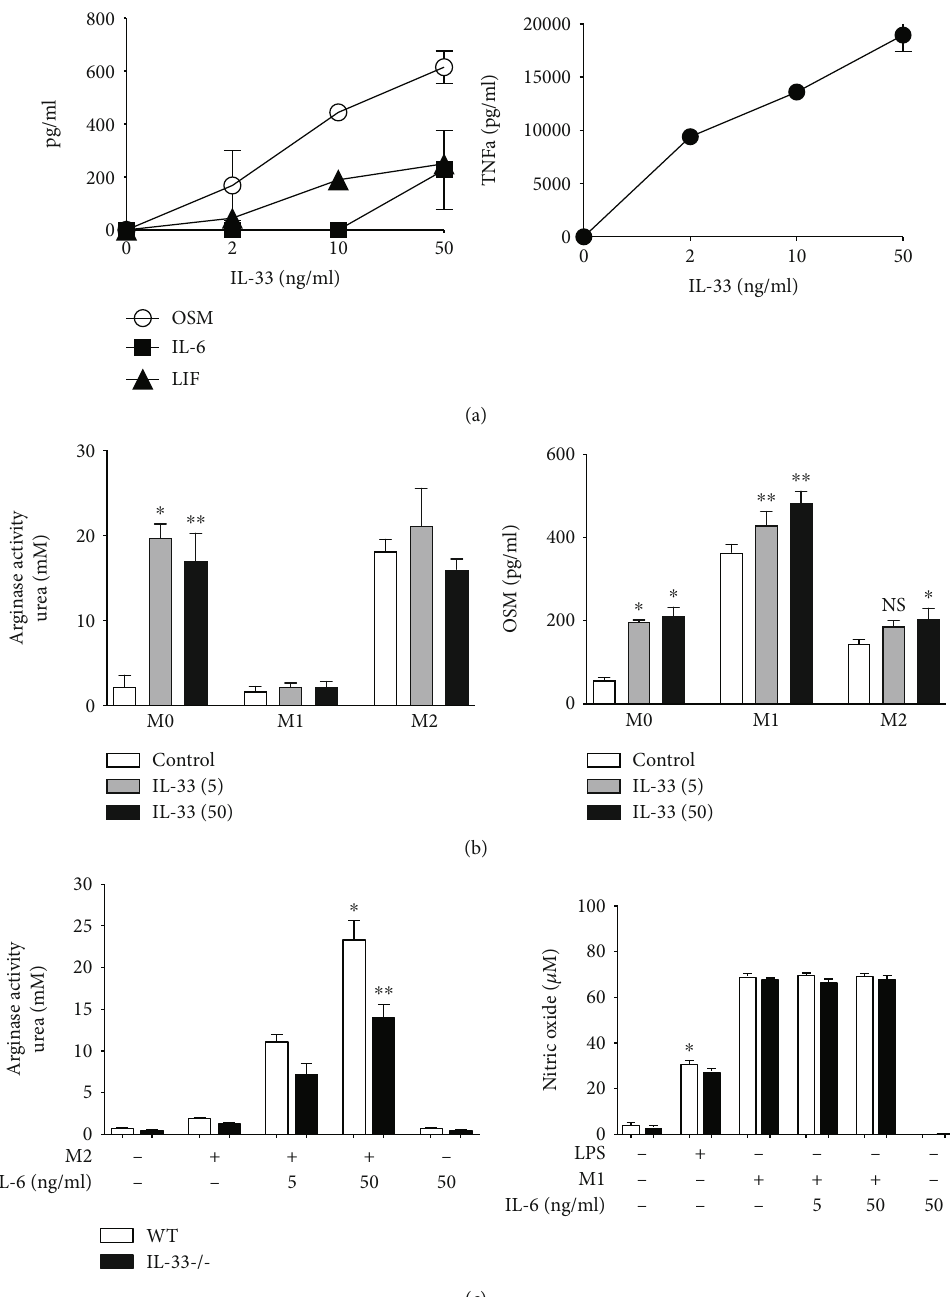
Figure 8: IL-33 stimulates production of IL-6-type cytokines (OSM, IL-6, and LIF) and arginase-1 activity from macrophages. (a) RAW264.7 cells were stimulated with varying doses of recombinant mouse IL-33 (0-50ng/ml). After 48 hours, cell culture media was collected and assayed for the presence of OSM, IL-6, LIF, and TNFalpha (TNFa) by ELISA. Four replicates/treatment. (b) Bone marrow-derived macrophages (BMDM) were di ff erentiated into M1- (LPS+IFN γ ) or M2-type (IL-4+IL-13) macrophages or remained untreated (M0) and stimulated with 5 or 50ng/ml of IL-33 for 24 hours. Cell lysates were assayed for arginase-1 activity (urea production) and supernatants assayed by ELISA for Oncostatin M (OSM). (c) BMDM cells from wild-type or IL-33-/- mice were di ff erentiated into M1 or M2 cells or treated with LPS alone with or without IL-6 (a potentiator of M2 cells) and assayed for arginase-1 activity or nitric oxide production. Four replicates/treatment. ∗ p < : 01 , ∗∗ p < : 001